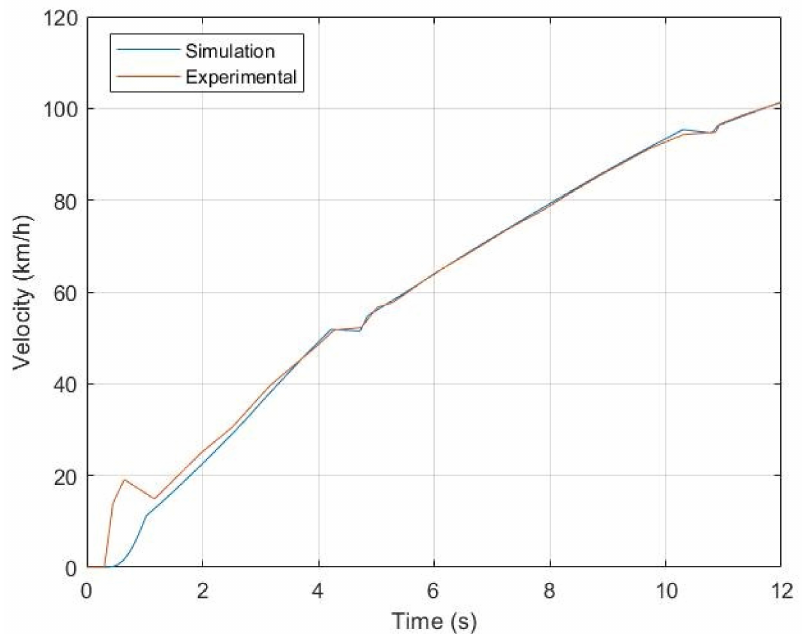
Figure 3. Maximum acceleration comparison between measured and simulated